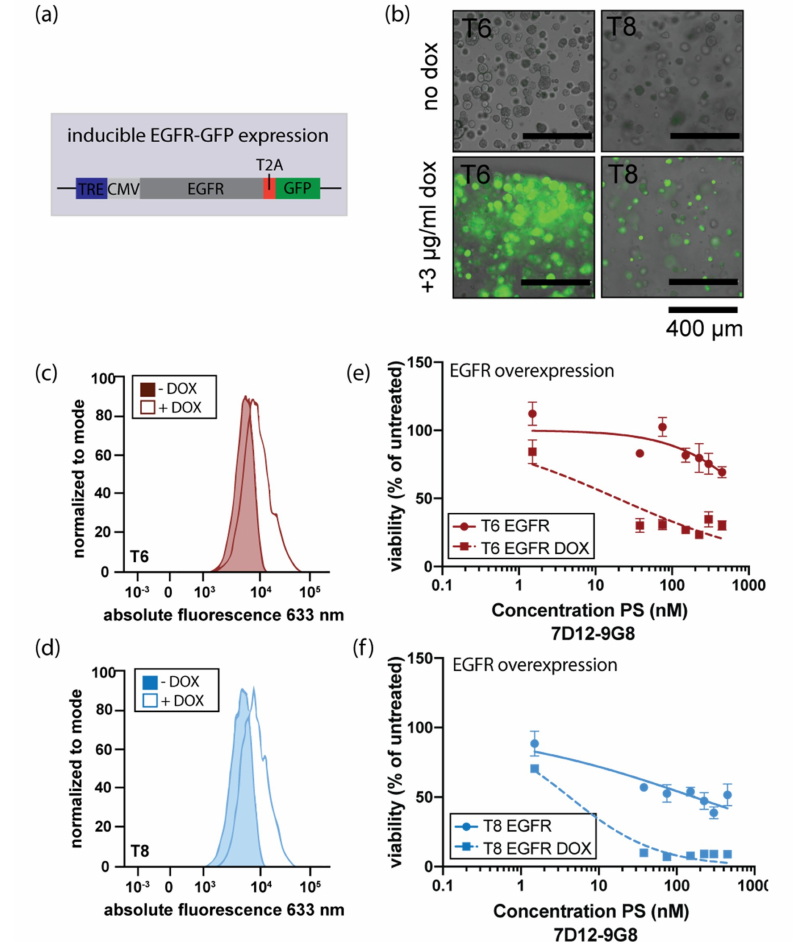
Figure 4. Induced EGFR expression enhances the response to EGFR-targeted PDT. ( a ) Schematic outline of lentiviral infector used to create organoid lines that can be induced to overexpress EGFR (TRE: tetracycline responsive element, CMV: cytomegalovirus promotor). The TRE and CMV promotor precede the open reading frame encoding EGFR and GFP, separated by a T2A sequencing, assuring generation of separate mRNA molecules for EGFR and GFP. ( b ) Merged brightfield / immunofluorescence images of organoids after two-day administration of doxycycline. Scalebar 400 µ m. ( c ) and ( d ). E ff ect of doxycycline-mediated EGFR overexpression on EGFR protein levels in organoid lines T6 and T8, respectively. Colored peaks indicate uninduced expression, lined peaks indicate induction of EGFR expression. ( e ) and ( f ). EGFR-targeted PDT using nanobody 7D12-9G8-PS in EGFR overexpressing organoid lines T6 and T8. Organoids were either doxycycline-induced (squared symbols, dashed line) or uninduced (round symbols, solid line) and exposed to PDT as previously